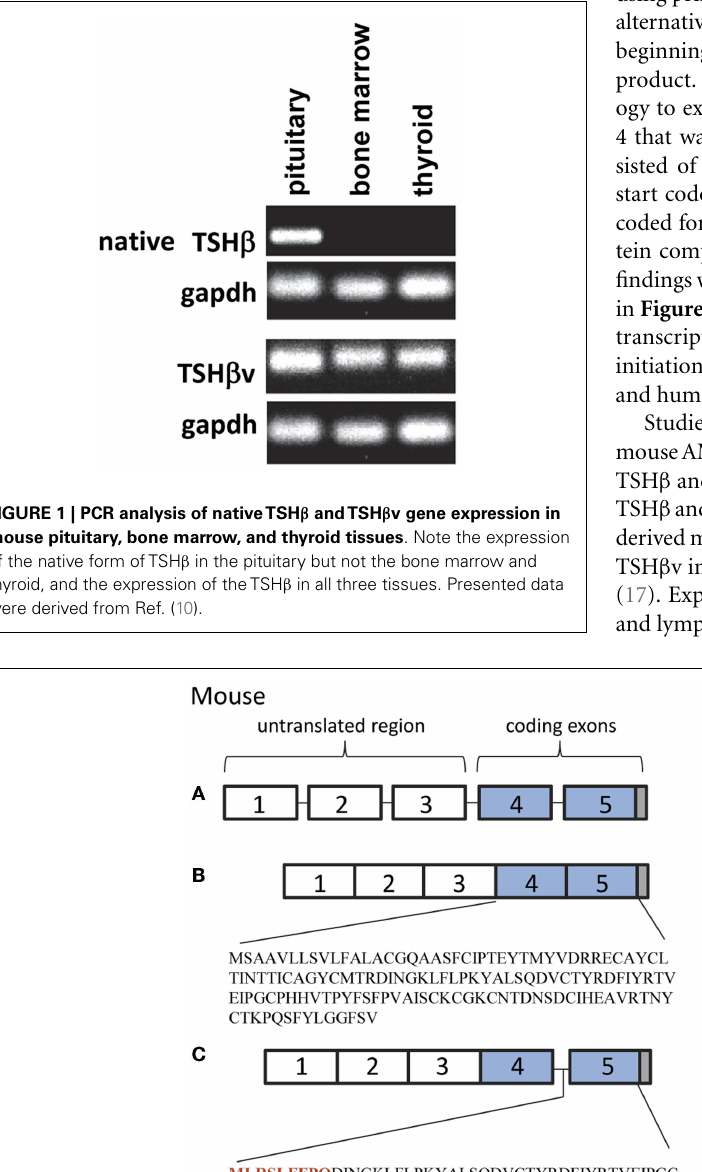
humans.The 27 nucleotide 3 (cid:48) end of intron 4 in mouse and intron 2 in humanTSH β v codes for a nine amino acid signal peptide (shown in red) beginning with a methionine translational start site. Gray boxes represent stop